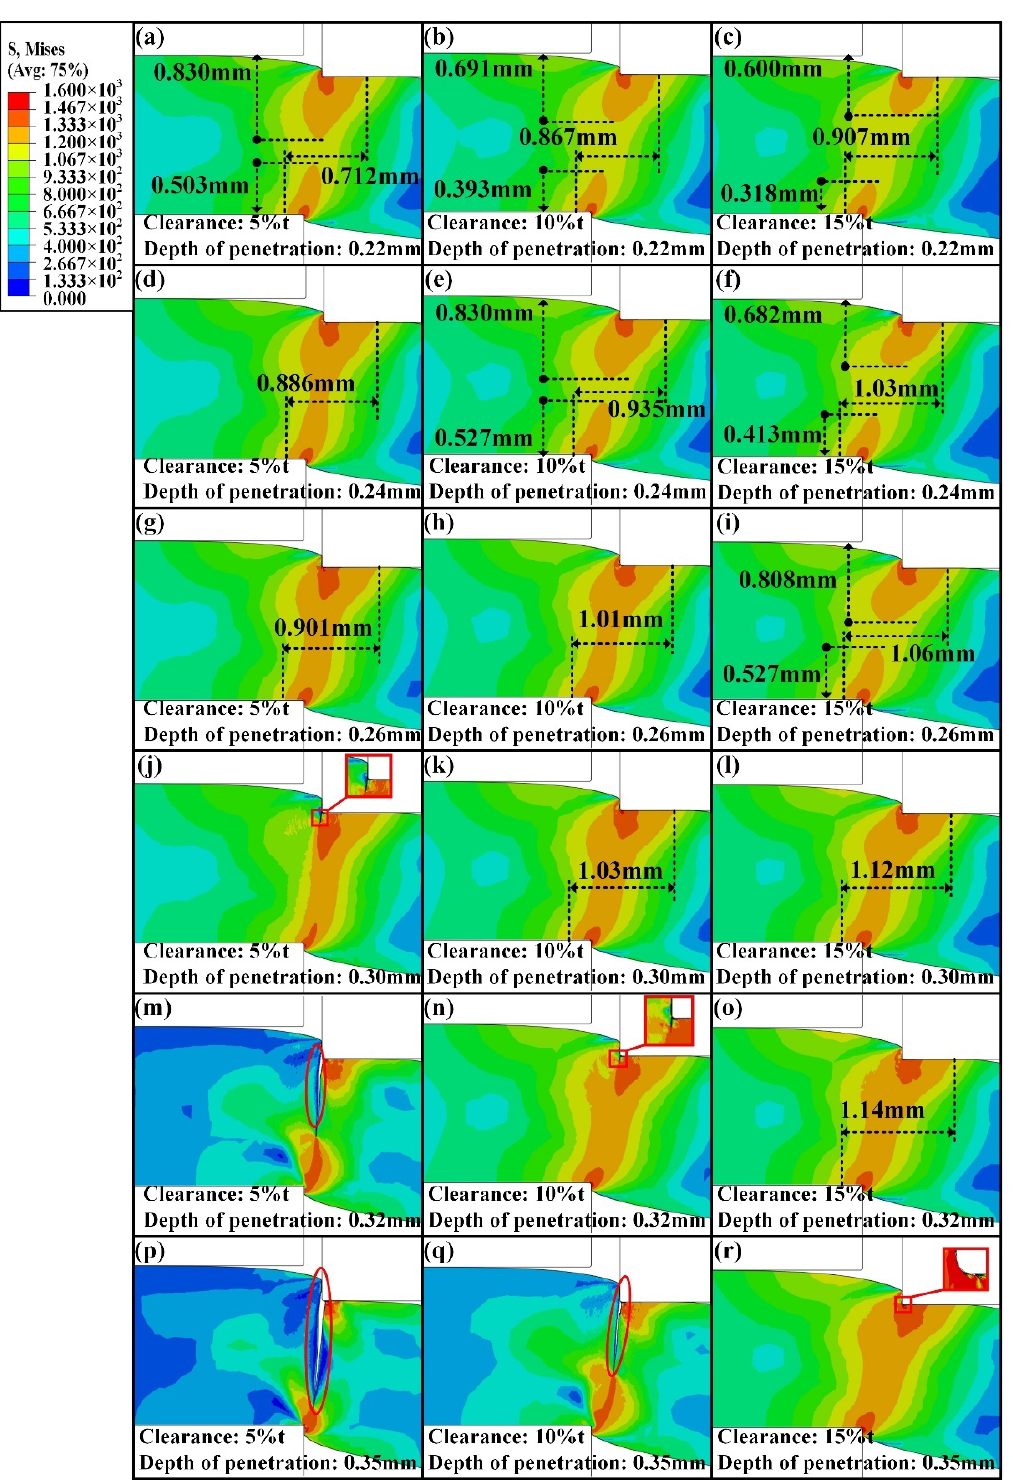
Figure 28. Stress distribution under the shearing clearances of 5%t, 10%t, and 15%t at different stages during the shearing process. ( a – c ) Depth of penetration = 0.13 mm. ( d – f ) Depth of penetration = 0.15 mm. ( g – i ) Depth of penetration = 0.17 mm. ( j – l ) Depth of penetration = 0.24 mm. ( m – o ) Depth of penetration = 0.26 mm. ( p – r ) Depth of penetration = 0.29 mm.